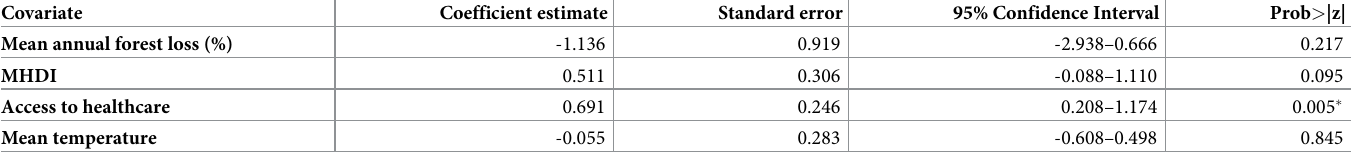
Table 4. Parameter estimates for covariates.